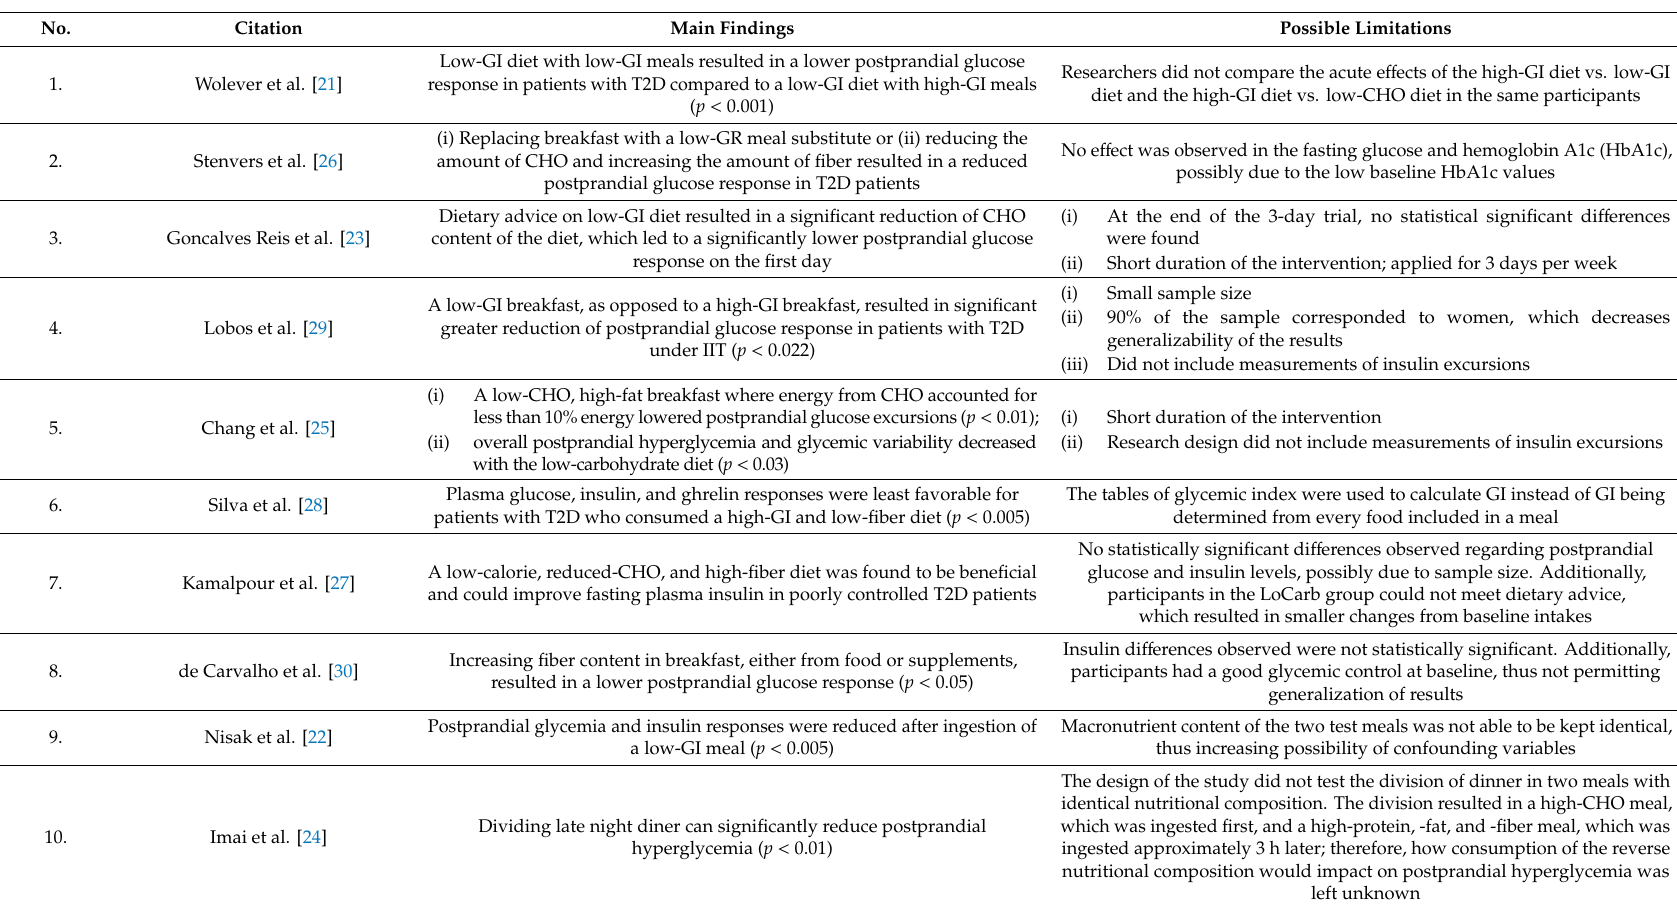
Table 3. Main findings and possible limitations of each